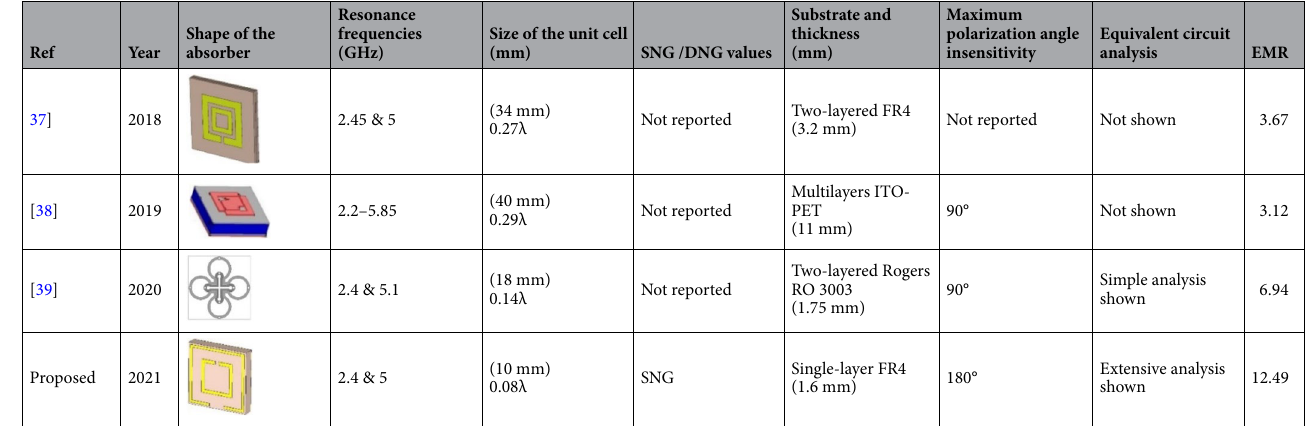
Table 2. Comparison of the proposed wifi absorber with most relevant